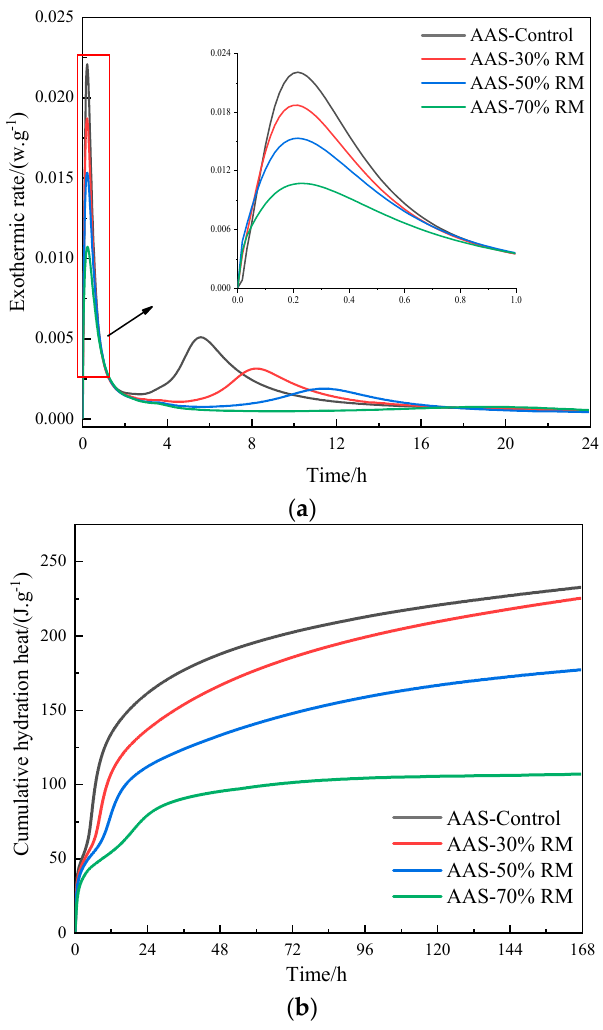
Figure 6. Exothermic rate curve of AASR ( a ) and cumulative hydration heat ( b ).